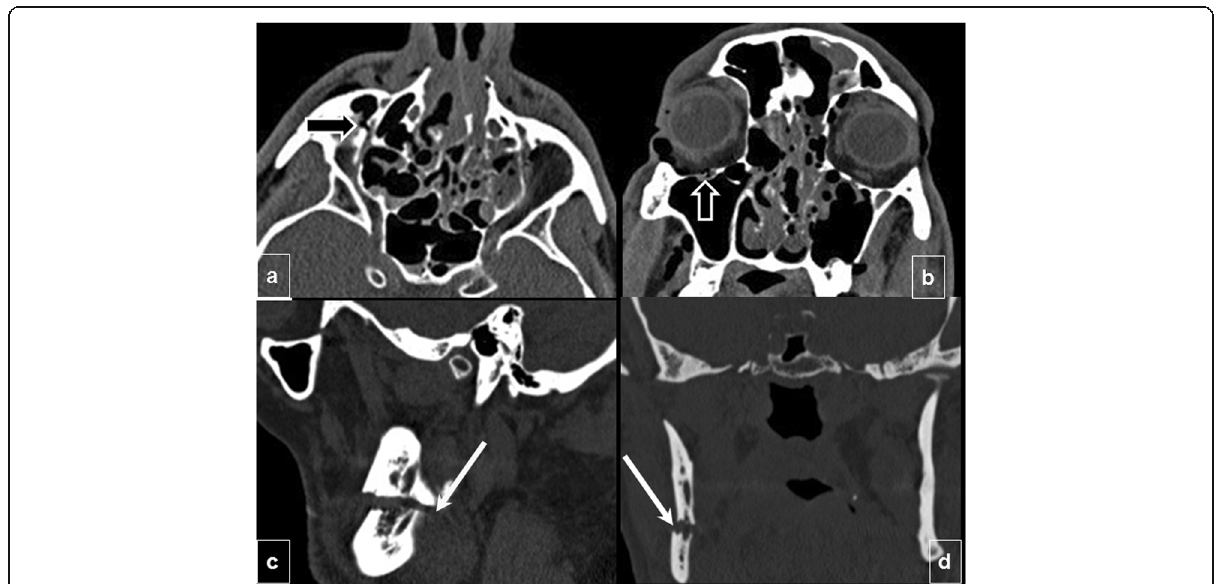
Fig. 3 Neural foramina complications. Infraorbital canal injury: ( a ) Axial and ( b ) coronal CT images show a Le Fort II fracture passing through the infraorbital canal, which can affect the infraorbital nerve (terminal branch of CN V2) (black arrow). c , d Mandibular canal injury: ( c ) Sagittal and ( d ) coronal views of a unifocal mandibular fracture passing through the mandibular canal with mild displacement (white arrows) that may damage the inferior alveolar nerve (a branch of CN